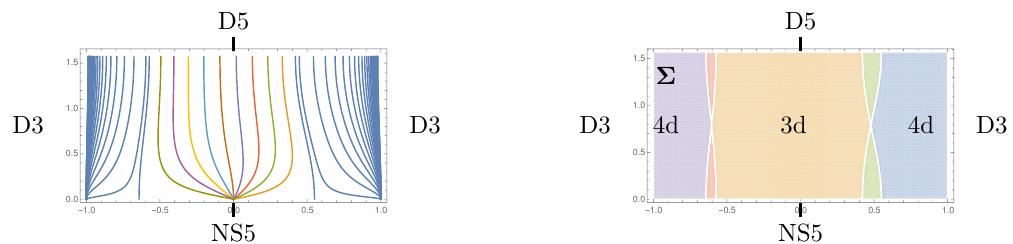
Figure 15. D5 0 embeddings and identification of 3d and 4d regions for a Janus solution, with harmonic functions (4.10) with N 5 D5-branes at z = iπ of semi-infinite D3-branes to the left and right fixed by L = 1